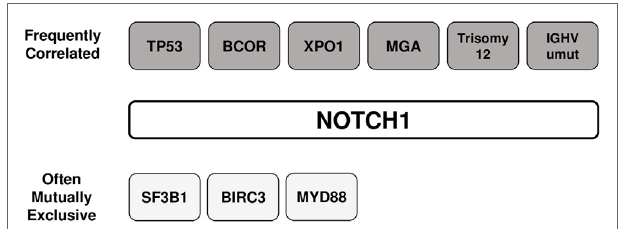
FigURe 5 | Association between NOTCH1 mutations and other genetic features in chronic lymphocytic leukemia. The patterns of co-occurrence and mutual exclusivity between NOTCH1 mutations and other genetic features are